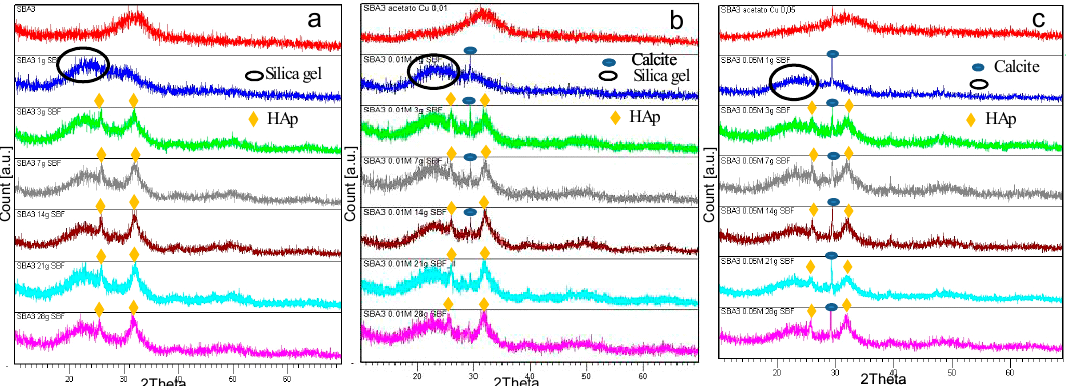
Figure 9. XRD spectra of SBA3 ( a ); SBA3-Cu0.01 ( b ); and SBA3-Cu0.05 ( c ) before and after immersion in simulated body fluid (SBF) for 1, 3, 7, 14, 21, and 28 days. HAp: Hydroxyapatite.